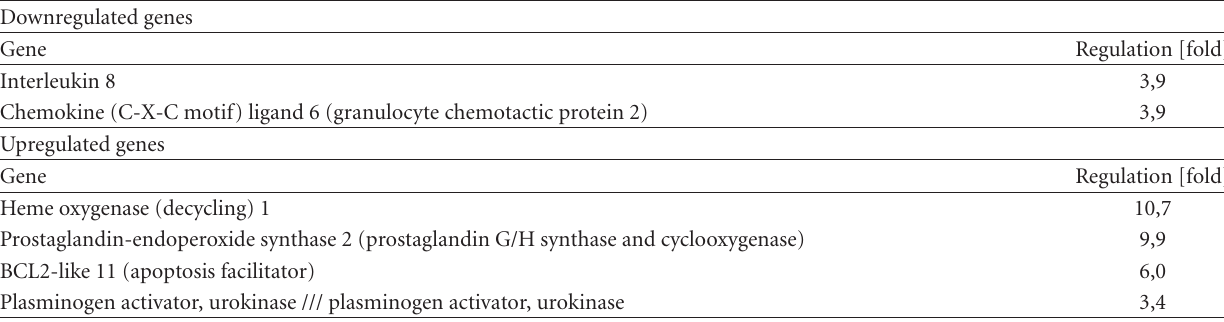
Table 1: Di ff erential expression of selected genes Confirmation of gene expression profiles of the 6 listed selected genes was performed by Real-time RT PCR, western blot or ELISA